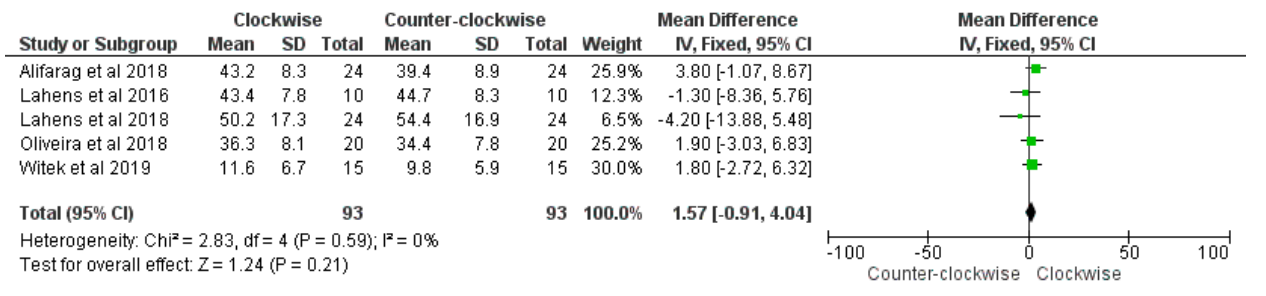
Figure 14. Forest plot of comparison of insertion torque, of the BAFO (right) and counter-clockwise procedure (left).